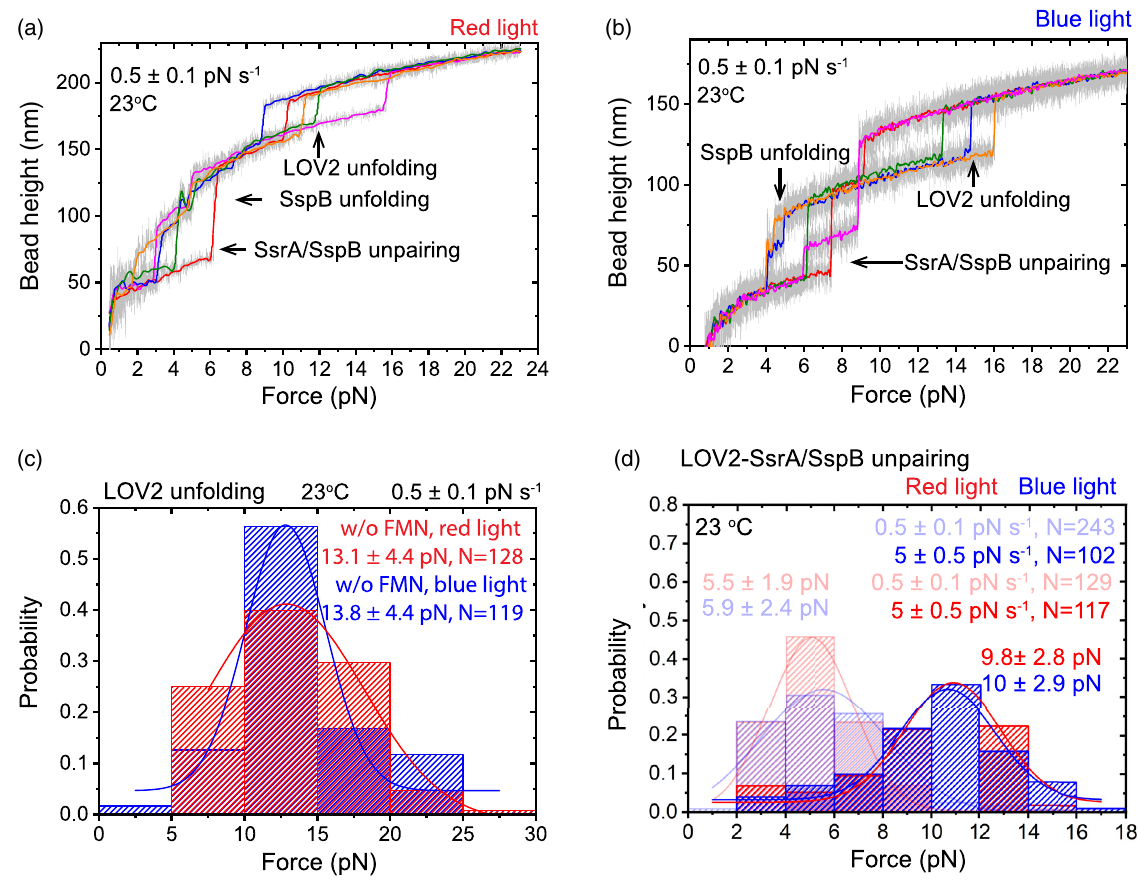
FIG. 4. Mechanical stability of the apo LOV2-SsrA/SspB complex. (a),(b) Five representative force-extension curves of the apo LOV2-SsrA/SspB complex obtained in red light and in blue light, respectively, at a force-loading rate of 0 . 5 (cid:1) 0 . 1 pN s − 1 , indicated by multiple colors. The colored lines are 20-FFT smooth of the raw data (gray). (c) Normalized histograms of apo LOV2 unfolding forces with a loading rate of 0 . 5 (cid:1) 0 . 1 pN s − 1 obtained in red light (red) and blue light (blue), respectively. N indicates the number of data points. The colored lines in (c) and (d) are corresponding Gaussian fitting curves. (d) Normalized histograms of apo LOV2-SsrA/SspB complex unpairing forces at a force-loading rate of 0 . 5 (cid:1) 0 . 1 and 5 (cid:1) 0 . 5 pN s − 1 obtained in red light (red) and blue light (blue),